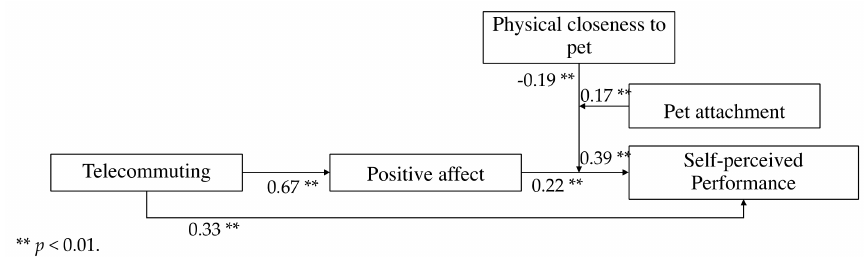
Figure 3. The moderated moderated mediation model with the